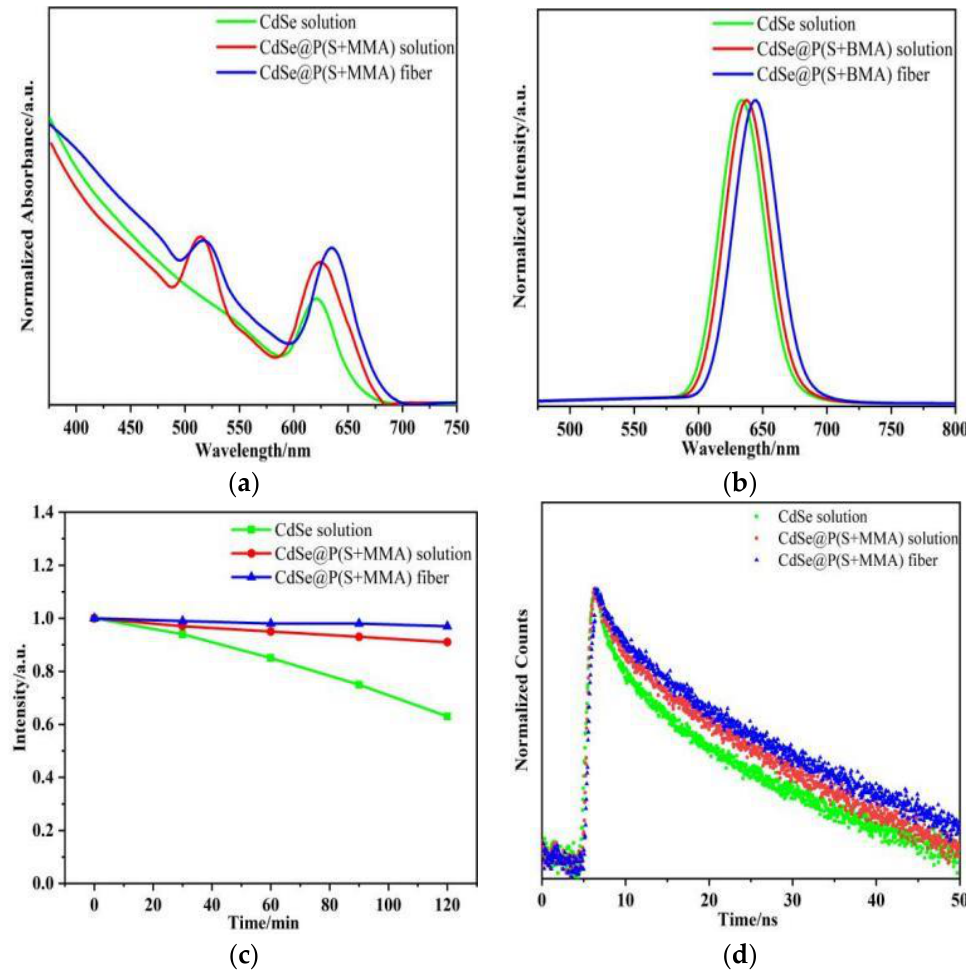
Figure 4. Absorption ( a ) and PL ( b ) spectra of CdSe QDs and CdSe@P(S+MMA) solution in trichloroethylene and CdSe@P(S+MMA) hybrid fibers. ( c ) Photostability of PL signal from CdSe QDs, CdSe@P(S+MMA) solution in trichloroethylene, and CdSe@P(S+MMA) hybrid fibers under 2 h UV lamp irradiation. ( d ) PL decay curves for CdSe QDs and CdSe@P(S+MMA) solution for trichloroethylene and CdSe@P(S+MMA) hybrid fibers. λ exc = 450 nm.